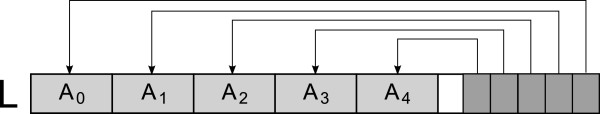
Overflow List L. The overflow list L is implemented as a byte array. Alignments are inserted from the start of the array. In the picture A0,A1,…A4 are contained. Pointers to the respective starting positions are inserted from the end of the byte array.